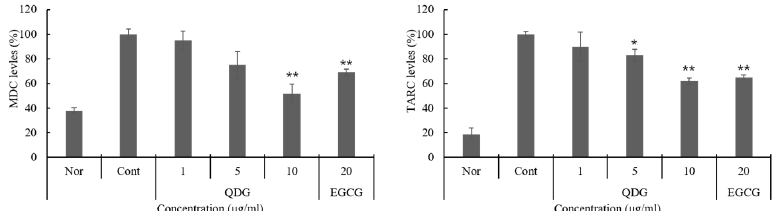
Figure 3. Effect of QDG treatment on macrophage-derived chemokine (MDC) and thymus- and activation-regulated chemokine (TARC) expression in HaCaT cells. HaCaT cells were treated with different concentrations of QDG (1, 5, and 10 μ g/mL) after irradiation with 20 mJ/cm 2 UVB. After 24 h, chemokine expression was determined in the cell supernatant according to the kit manual. Each value represents mean ± SD for the three individual experiments. Nor: No treatment cell group (0 h), Cont: 20 mJ/cm 2 UVB treatment cell group, QDG = QDG treatment group, EGCG = positive control. n = 3. * = p < 0.001 and ** = p < 0.0001 compared with the control group.